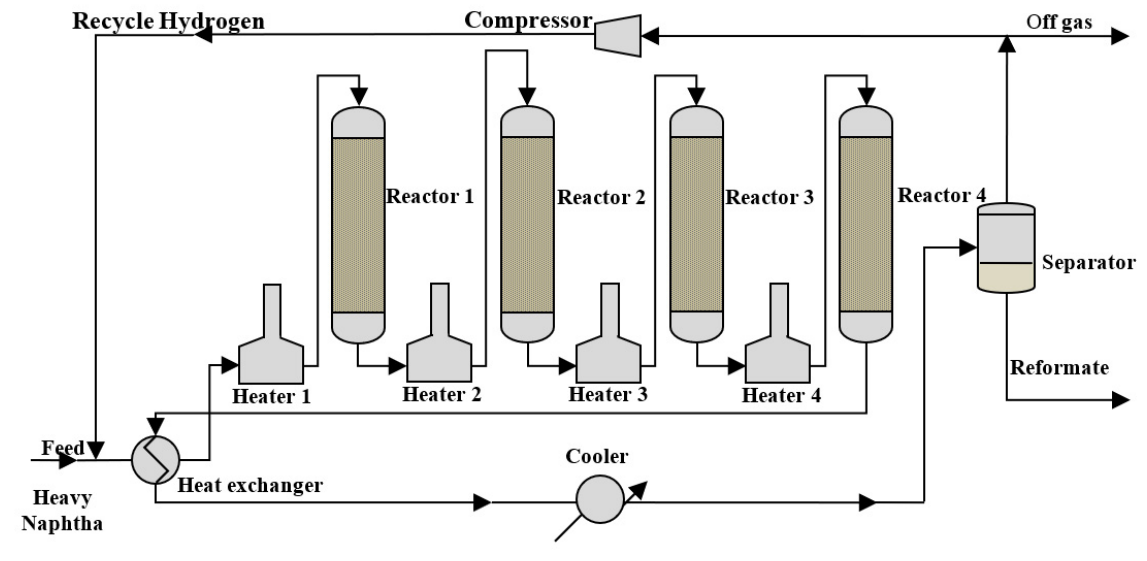
Figure 1. Flow sheet of the semi-regenerative naphtha reforming unit. Ten datasets were collected from the commercial heavy naphtha reforming process in a long time period (1225 days), starting after using a fresh catalyst in the reactors. Each dataset contains information about the weight fractions of the streams, catalyst loading, and operating conditions for the commercial heavy naphtha reforming unit (see Table